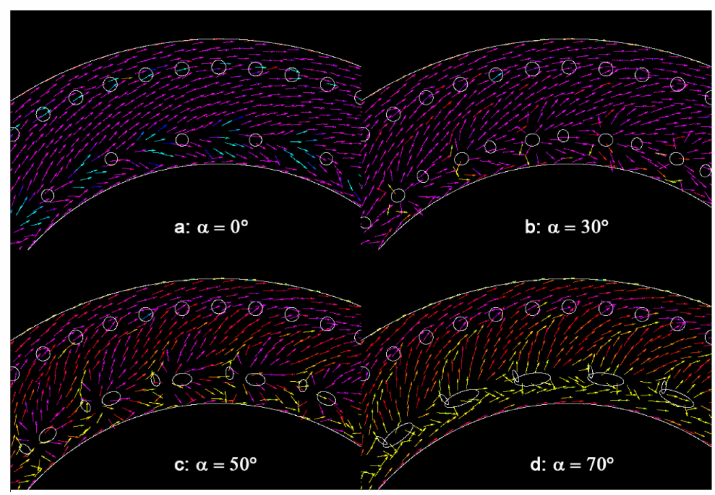
Figure 10. Vector at the plane z = 0.5 for different pre-swirl angles: ( a ) α = 0 ◦ , ( b ) α = 30 ◦ , ( c ) α = 50 ◦ ,